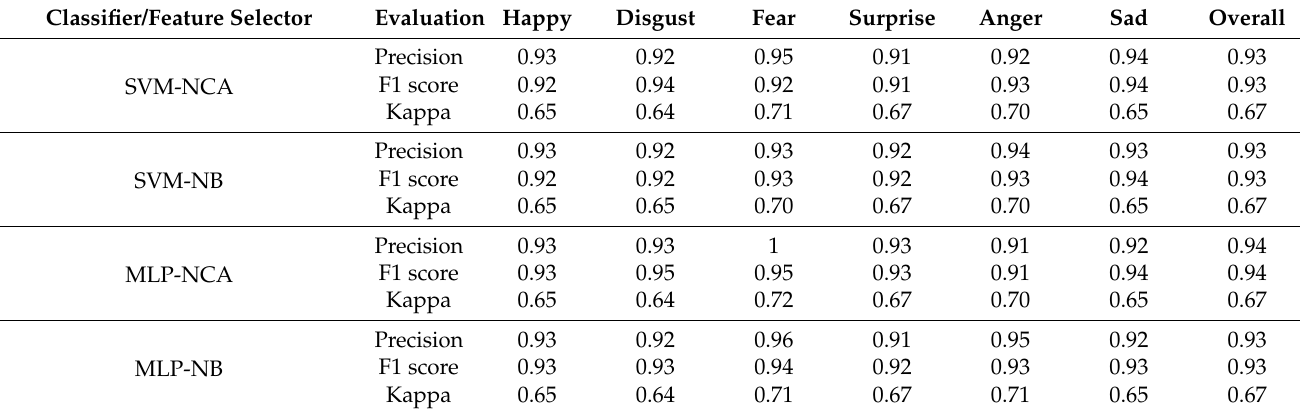
Table 6. Precision, F1 score, and Kappa statistical evaluation method reported from classification human affective state recognition based on selective 11 sub-ROIs and SVM and MLP classifiers with NCA and NB feature selection